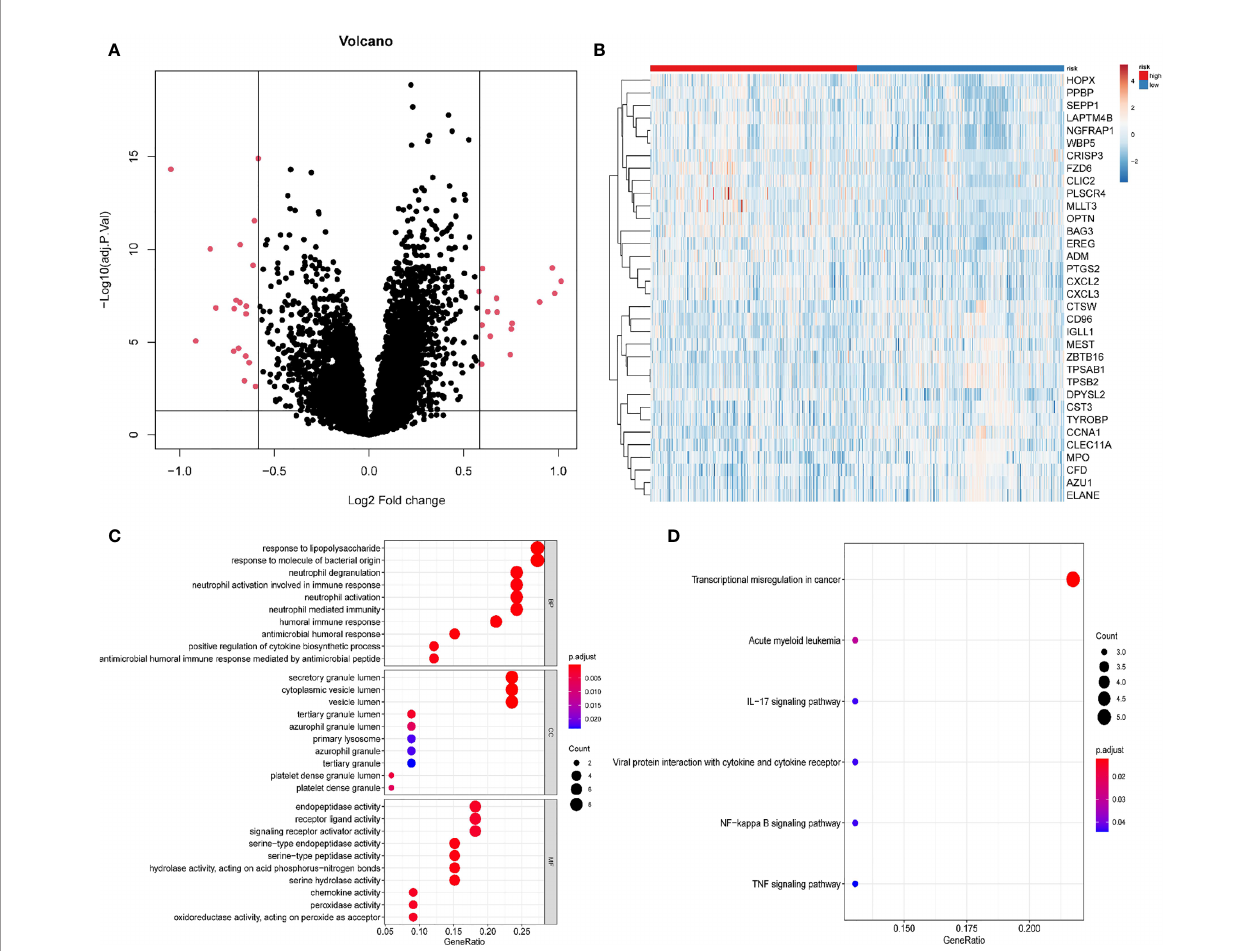
FIGURE 5 | Differentially expressed genes (DEGs) between the high-risk and the low-risk groups. (A) Volcano plot of the DEGs. (B) Heatmap of the DEGs. (C) Signi fi cantly enriched GO terms of the DEGs. (D) Signi fi cantly enriched pathways of the